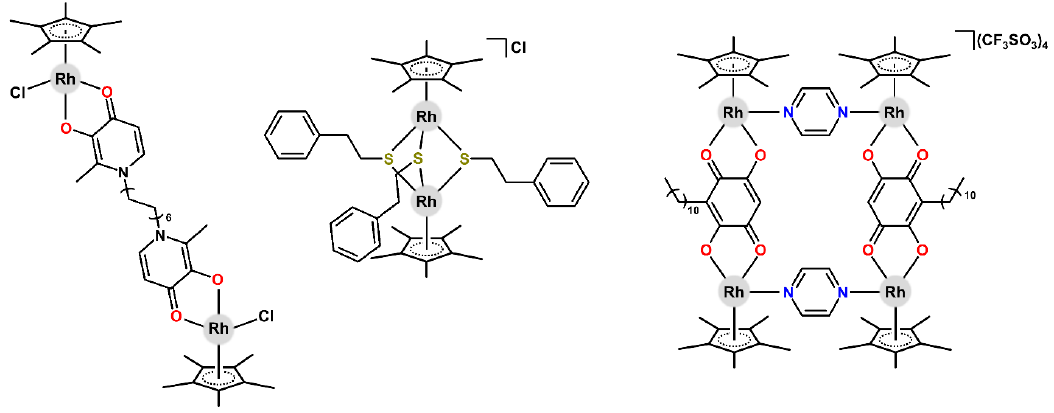
Figure 9. Structural formulas of complexes [Rh 2 ( μ -mal 1 )( η 5 -Cp*) 2 Cl 2 ] (left), [Rh 2 ( μ -SR 1 ) 3 ( η 5 -Cp*) 2 ]Cl (middle) and [Rh 4 ( μ -dhbq) 2 ( μ -pyz) 2 ( η 5 -Cp*) 4 ](CF 3 SO 3 ) 4 (right), with donor atoms given in red (O), dark yellow (S) or blue (N).